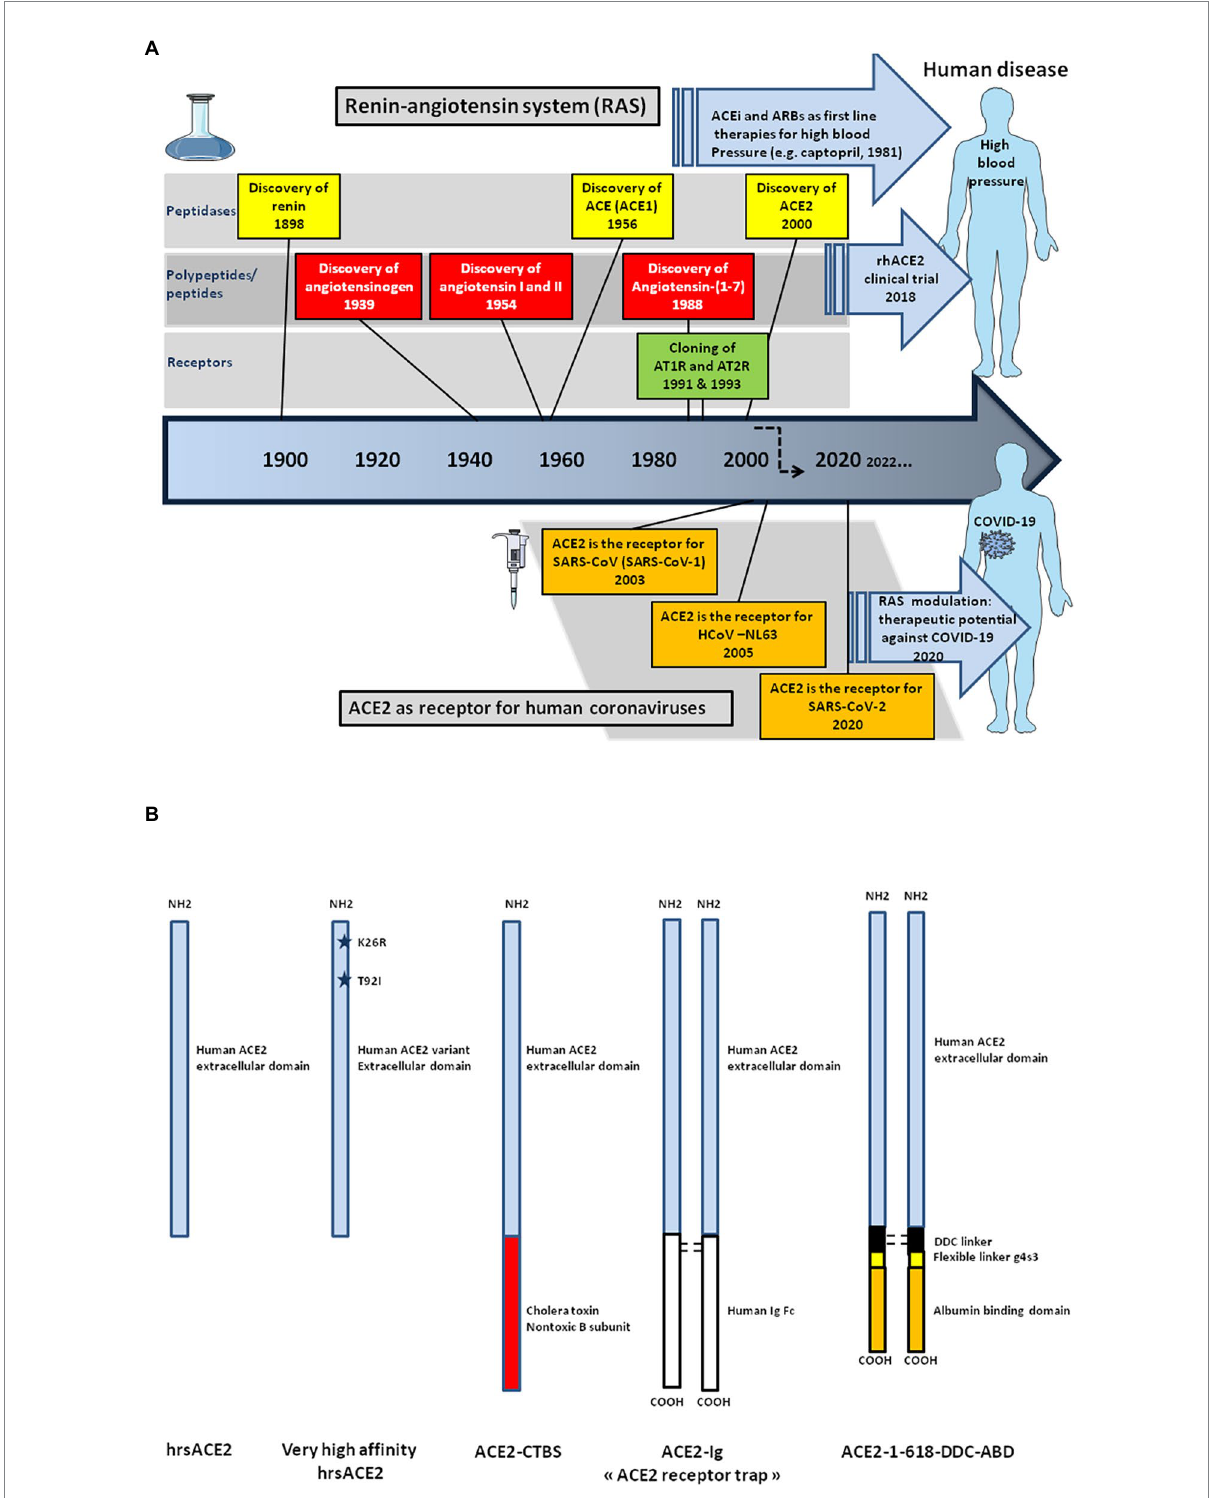
FIGURE 10 Schematic representation of the historical discovery of the main components of the renin-angiotensin system (RAS) and ACE2 candidate therapeutic molecules. (A) In 1898, renin was the first component of the RAS to be discovered. Vasoconstriction of the renal artery was then shown to lead to high blood pressure, thus driving the discovery of hypertensin and angiotonin (a compound later termed angiotensin). Angiotensin was subsequently characterized, as well as two downstream conpounds, the Ang I and Ang II, respectively. The ACE peptidase responsible for processing of Ang I into Ang II was subsequently characterized in 1956. The first orally active angiotensin-converting